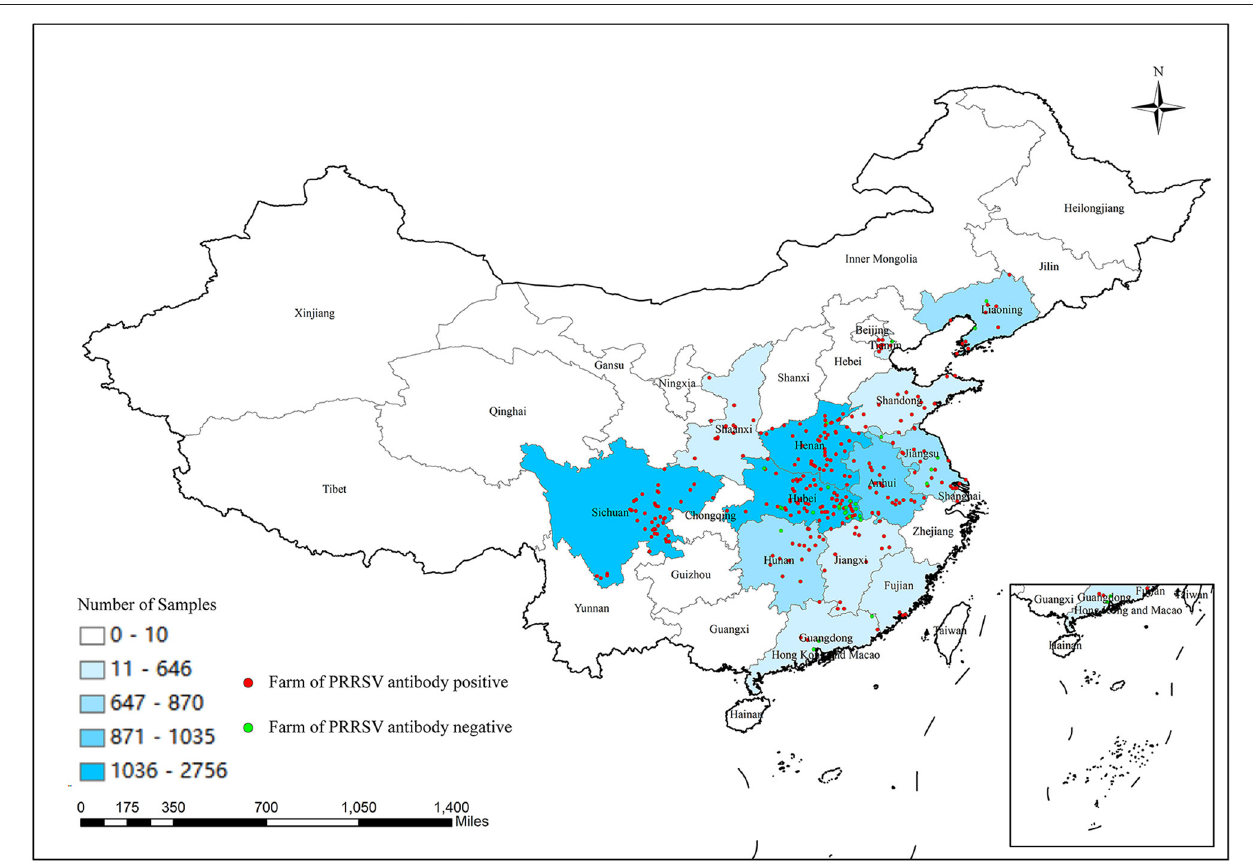
FIGURE 1 | Number of samples collected from different provinces or cities in China and location of selected pig farms.